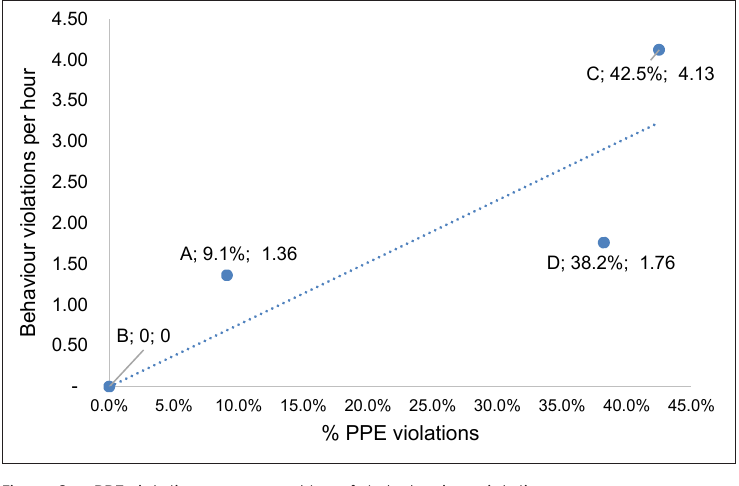
Figure 2: PPE violations compared to safety behaviour